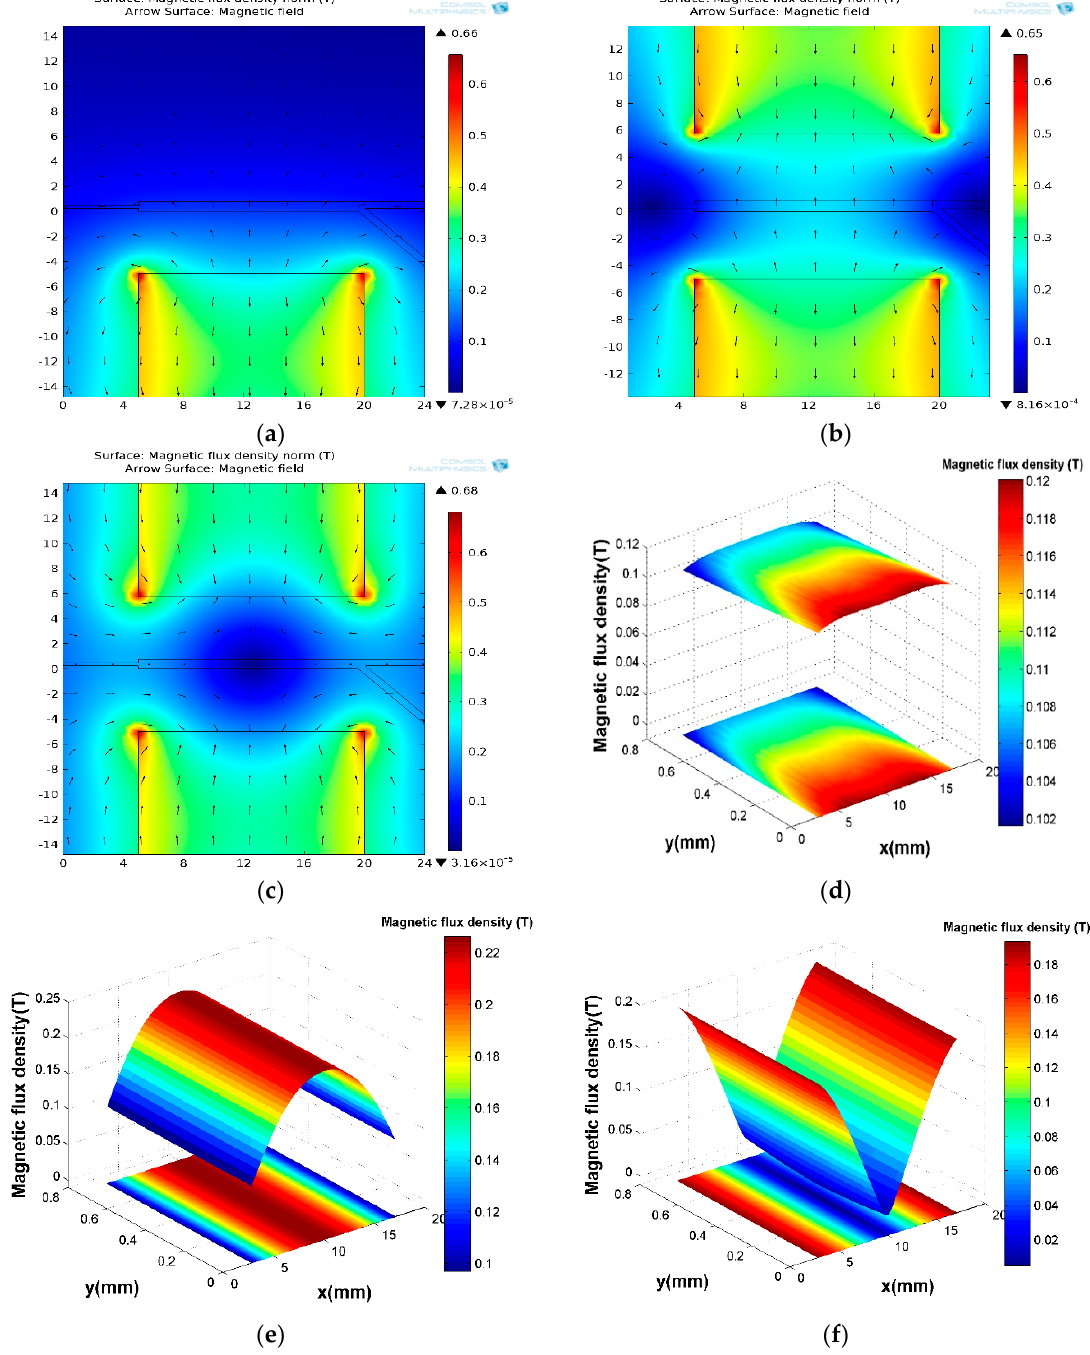
Figure 2. Schematic of surface plot and arrow plot of magnetic flux density: ( a ) Single magnet configuration; ( b ) Attractive magnet configuration; ( c ) Repulsive magnet configuration; The distribution of magnetic flux density within the microchannel for each model was plotted in a 3D surface plot at the bottom of surface plot, with the contour plot projected onto the x - y plane, labelled as ( d – f ).